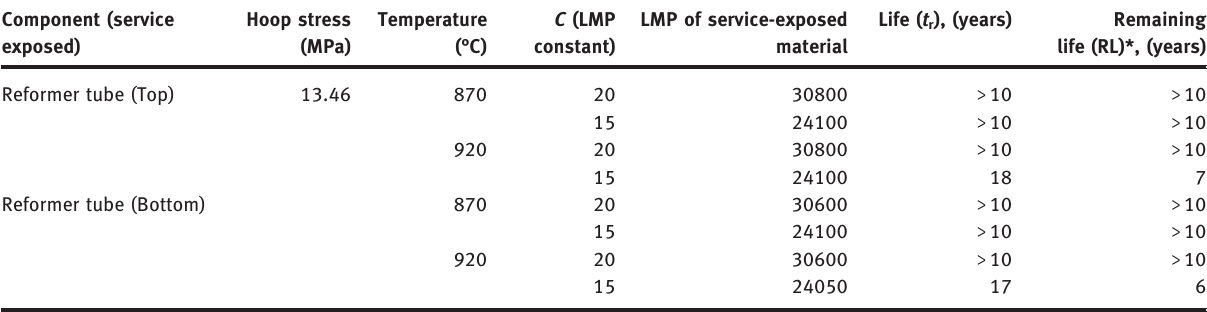
Table 1: Remaining life at different temperature with varying C (LMP constant) value. Component